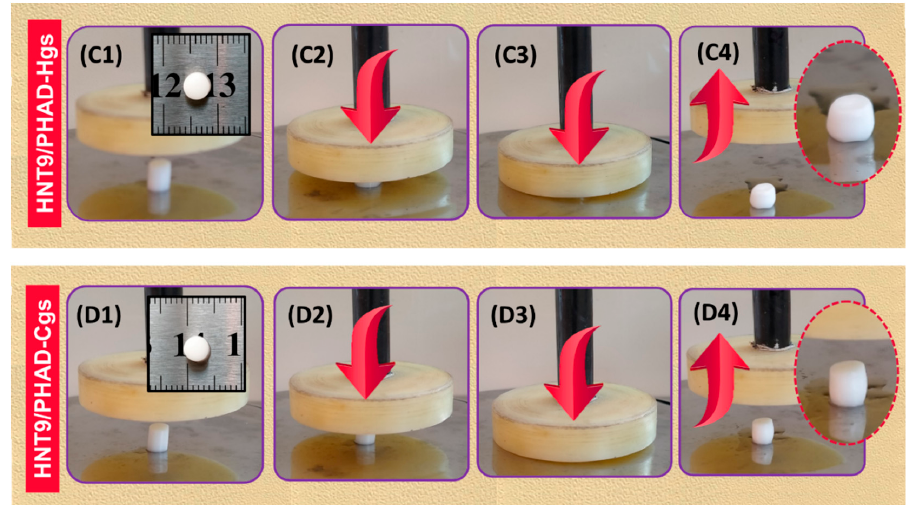
Figure 6. ( A ) Variation of compressive elastic moduli of ternary HNTm/PHAD-Hgs and -Cgs in the as-prepared state ( • ) and after equilibrium swelling in water ( ) with respect to HNT concentration; ( B ) comparison of swollen elastic modulus of ternary HNTm/PHAD-Hgs and -Cgs in water; ( C1 – C5 ) optical images during the uniaxial compression of swollen HNT9/PHAD-Hgs; and ( D1 – D5 ) optical images during the uniaxial compression of swollen HNT9/PHAD-Hgs containing 2.50% ( w/v ) HNT in the feed.